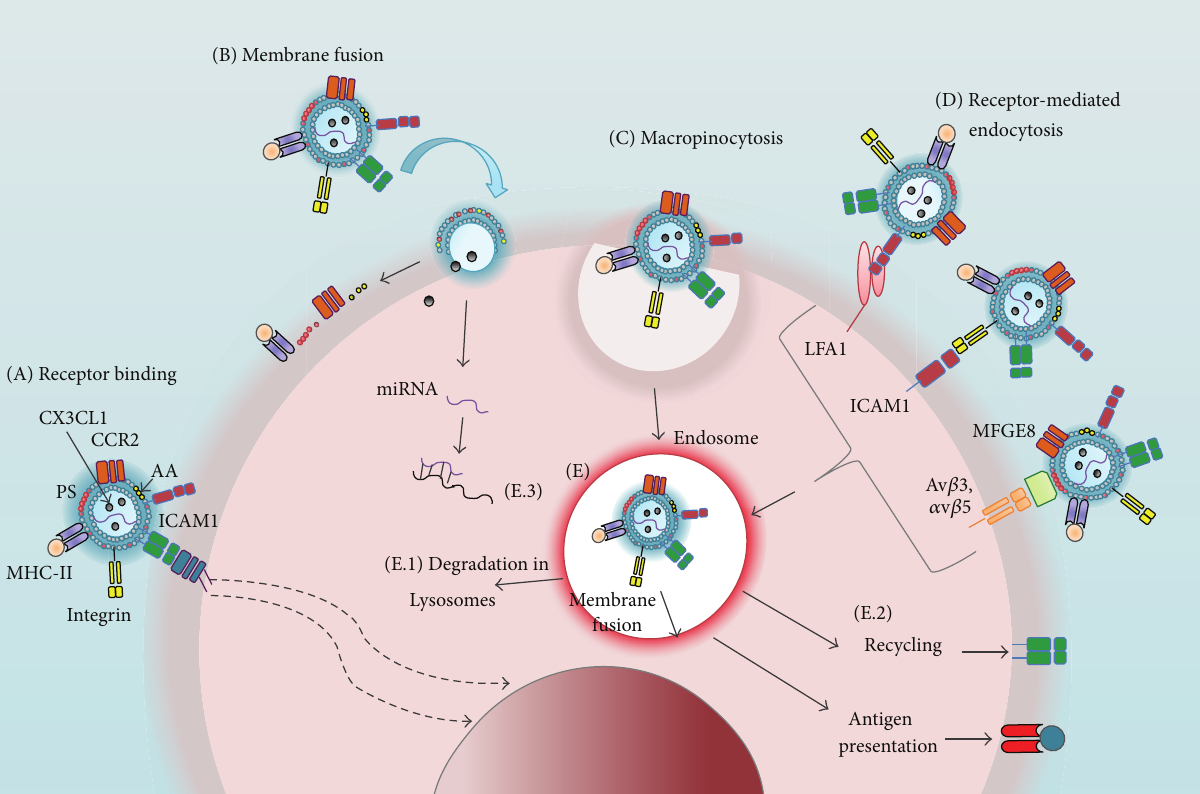
Figure 2: Interaction of MPs with their target cells. (A) MPs can interact with a variety of receptors on a target cell that may or may not lead to intracellular signaling (dashed arrows). Additionally, MPs can transfer their surface components (e.g., arachidonic acid (AA), PS) and internal proteins, receptors (MHC-II, CCR5), and nucleic acids (miRNA) to the target cell by (B) membrane fusion, (C) macropinocytosis, or (D) receptor-mediated endocytosis. In the latter, MPs can engage ligands such as LFA1 (lymphocyte function-associated antigen 1), intercellular adhesion molecule 1 (ICAM1), or through binding to integrins ( 𝛼 v 𝛽 3 or 𝛼 v 𝛽 5) by soluble proteins that recognize the PS MFGE8 (milk fat globule EGF factor 8 protein). (E) When antigen-presenting cells internalize MPs, these structures can take different pathways: (E.1) Degradation by the endocytic pathway and subsequent antigenic peptide presentation through MHC-II molecules. (E.2) Their components may be partially recycled to the surface of the target cell, leading to a gain of phenotype and/or function. (E.3) miRNA can modulate gene